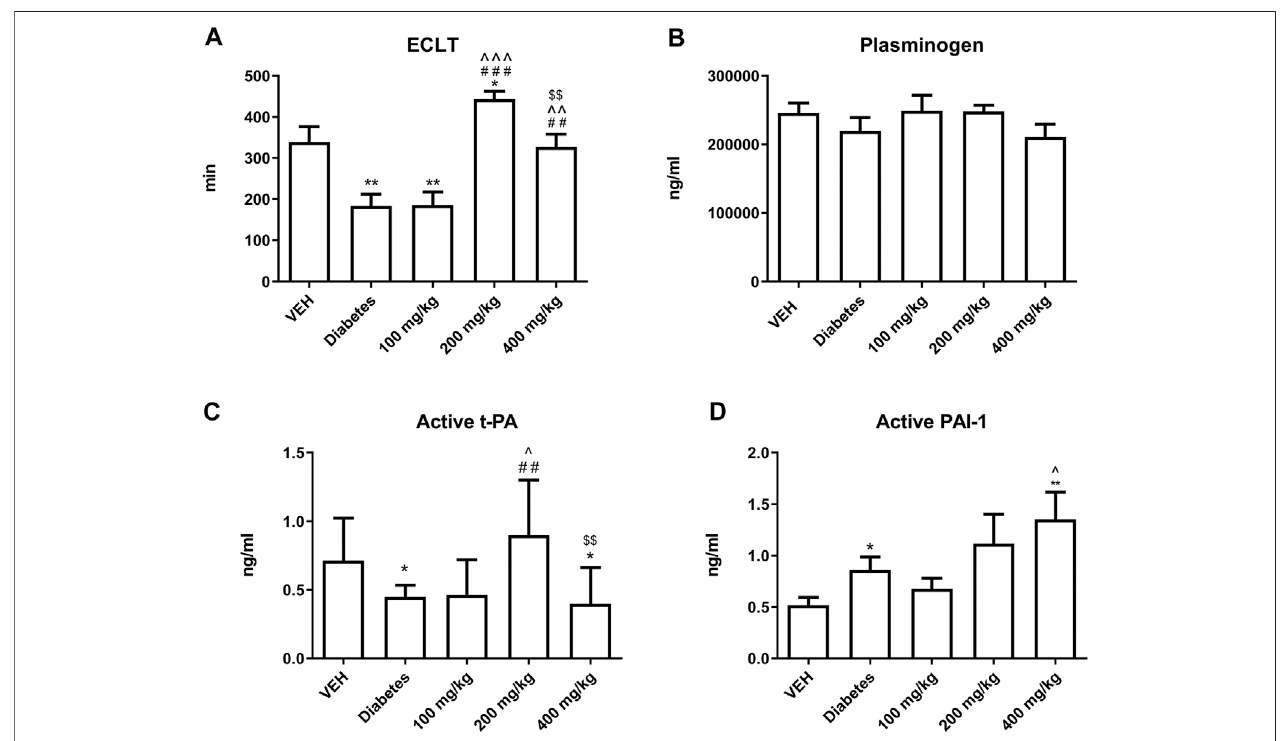
FIGURE9| TheeffectofTEon fi brinolysis.TheeffectofTEon:ECLT (A) ,plasminogenconcentration (B) ,concentrationofactiveformoft-PA (C) ,concentrationof active form of PAI-1 (D) . * p < 0.05, ** p < 0.01 vs. VEH; ## p < 0.01, ### p < 0.001 vs. Diabetes; ^ p < 0.05, ^^ p < 0.01, ^^^ p < 0.001 vs. 100 mg/kg; $$ p < 0.01 vs. 200 mg/kg; n (cid:2) 7 – 11. Data are shown as mean ± SEM.